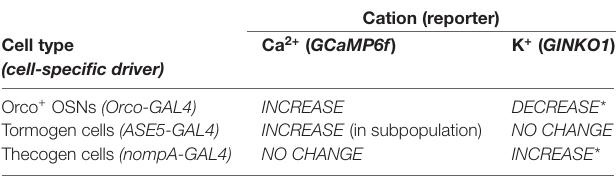
TABLE 2 | Summary of intracellular cation dynamics following odor presentation in neurons and support